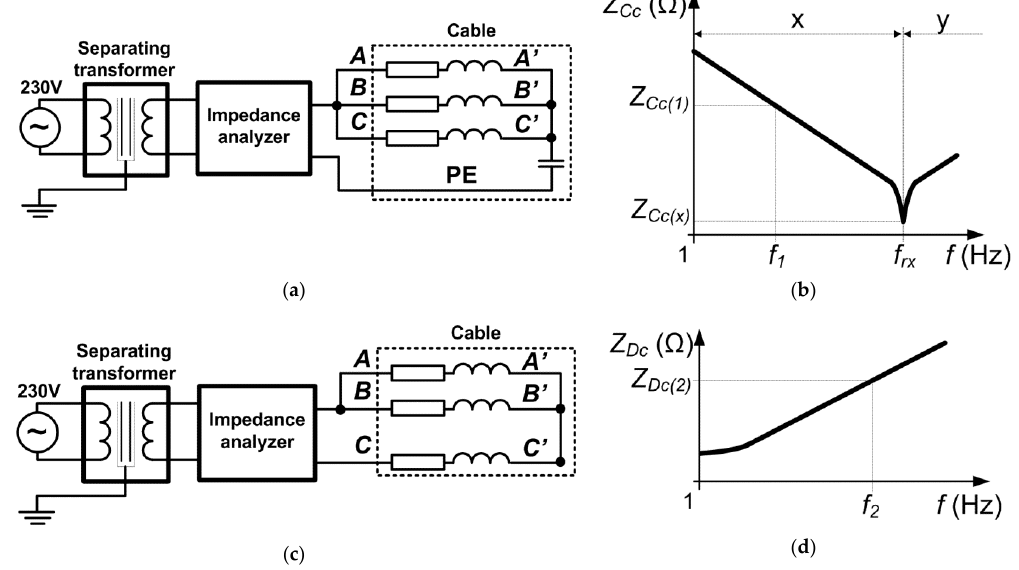
Figure 11. Measurement of cable model parameters: ( a ) measurement setup for Z Cc ( ω ) characteristic; ( b ) Z Cc ( ω ) characteristic; ( c ) measurement setup for Z Dc ( ω ) characteristic; ( d ) Z Dc ( ω ) characteristic.